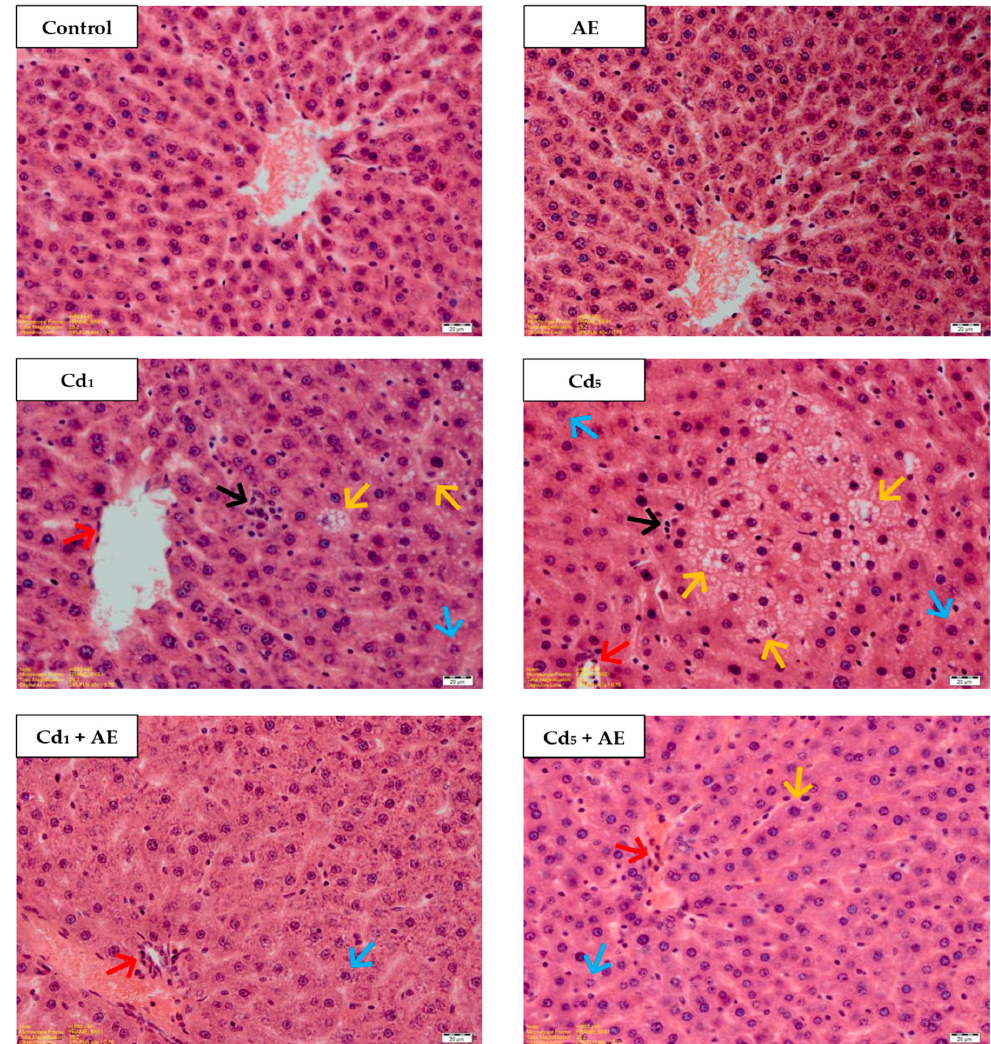
Figure 7. The effect of the extract from the berries of Aronia melanocarpa L. (AE) on the histological structure of the liver of rats exposed to cadmium (Cd) for 24 months. The rats received Cd in diet at the concentration of 0, 1, and 5 mg Cd/kg and/or 0.1% aqueous AE or not (H + E staining; ×400). Representative sections of the liver are presented. Control: normal liver in the control rats; AE: normal liver in the rats receiving 0.1% AE alone; Cd 1 group: blurred trabecular structure—in some lobes, vacuolization and enlarged cells dimensions—in some lobes ( ↑ ) , microvacuolar steatosis—in some lobes ( ↑ ), colliquative necrosis—in some lobes ( ↑ ), mononuclear cell infiltrations—in some lobes ( ↑ ); Cd 5 group: blurred trabecular structure—in some lobes, vacuolization—in majority of cells, in some lobes ( ↑ ) , colliquative necrosis—in some lobes ( ↑ ) , microvacuolar steatosis—in some lobes ( ↑ ), mononuclear cell infiltrations—in some lobes, ( ↑ ); Cd 1 + AE group: blurred trabecular structure, vacuolization and enlarged cells dimensions—in some cells in lobes ( ↑ ), mononuclear cell infiltrations ( ↑ ); Cd 5 + AE group: blurred trabecular structure—in some lobes, microvacuolar steatosis—in some lobes ( ↑ ) , vacuolization—in some lobes ( ↑ ) , mononuclear cell infiltrations ( ↑ ) . In the rats receiving AE during the exposure to Cd the changes in the liver morphology of the same type, but of different intensity as in the animals treated with this metal alone, were observed